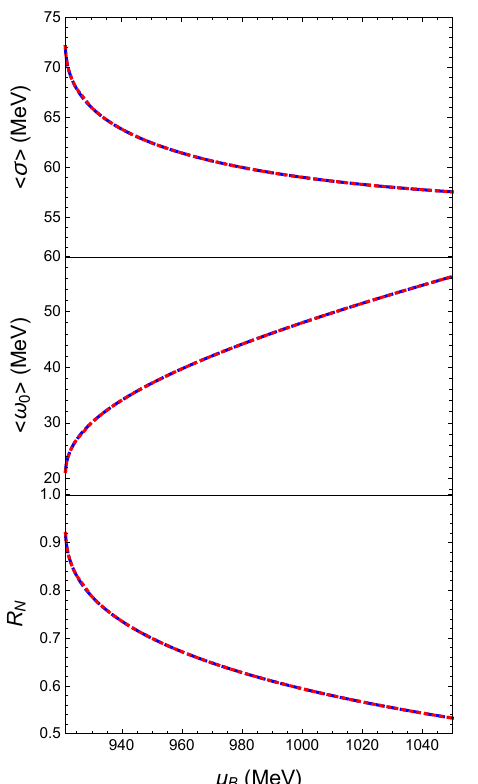
Figure 4 . The chiral condensate h (cid:27) i , vector condensate h ! 0 i and nucleon ratio R N as functions of chemical potential (cid:22) B in the chiral symmetry partially restored phase. The conventions are the same as those in (cid:12)gure